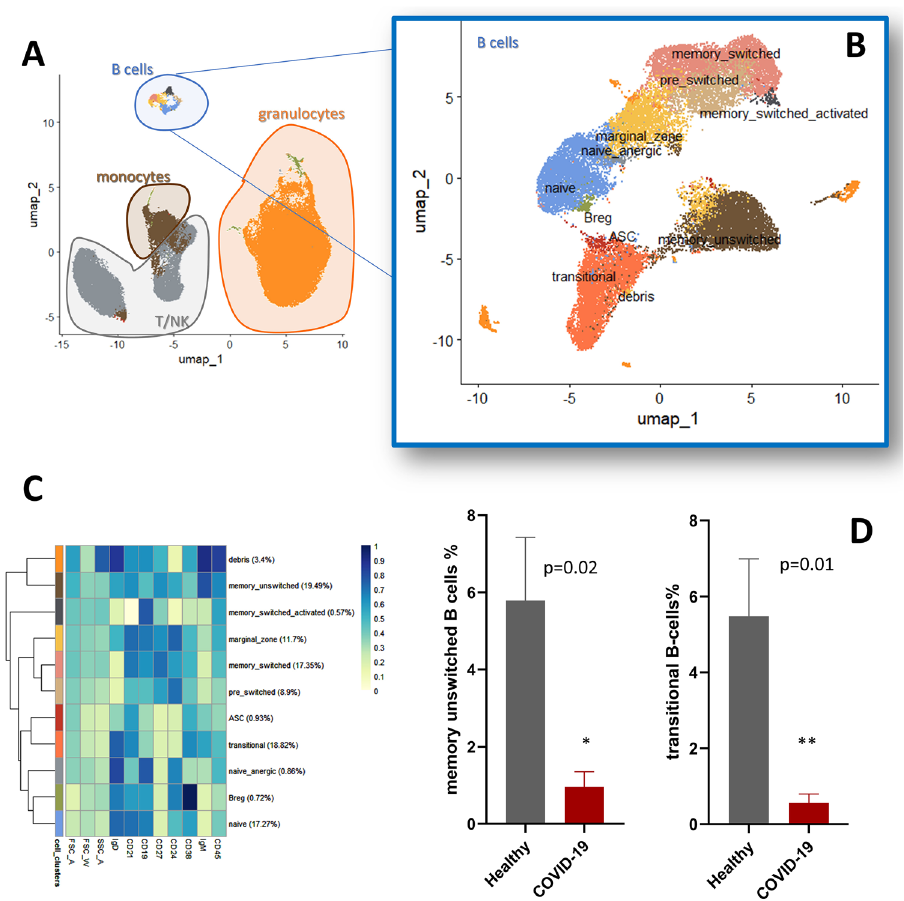
Figure 2. Dysregulation of B-cells composition in peripheral blood of COVID-19 patients. Cell composition and expression differences between COVID-19 and healthy peripheral blood. UMAP of CD45+ leukocytes (A) . Automatic prediction identifies different subsets in the B-cell -compartment (B) . MFI expression changes in B-cells (rows: identified sub-populations; columns: antigen of interest (C) . Memory-switched B cells and transitional B cells were lower in COVID-19 patients (red bars) than in healthy subjects (grey bars) (D) . *p < 0.005, **p < 0.001,